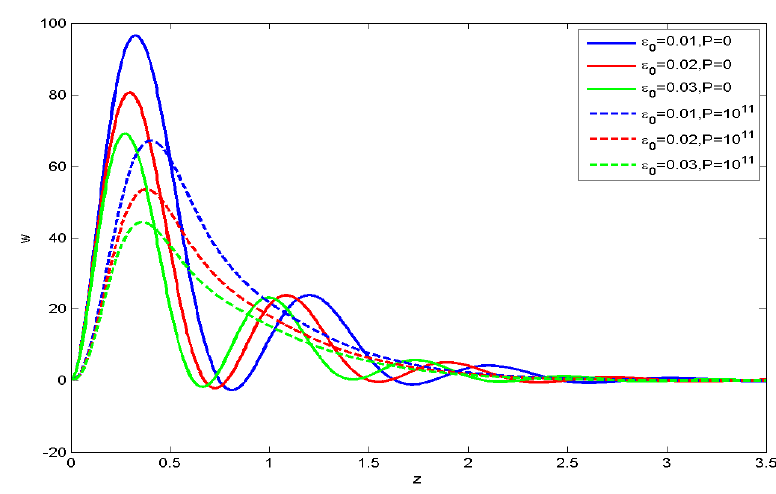
Figure 11. Vertical displacement w concerning z with electric field ε 0 .